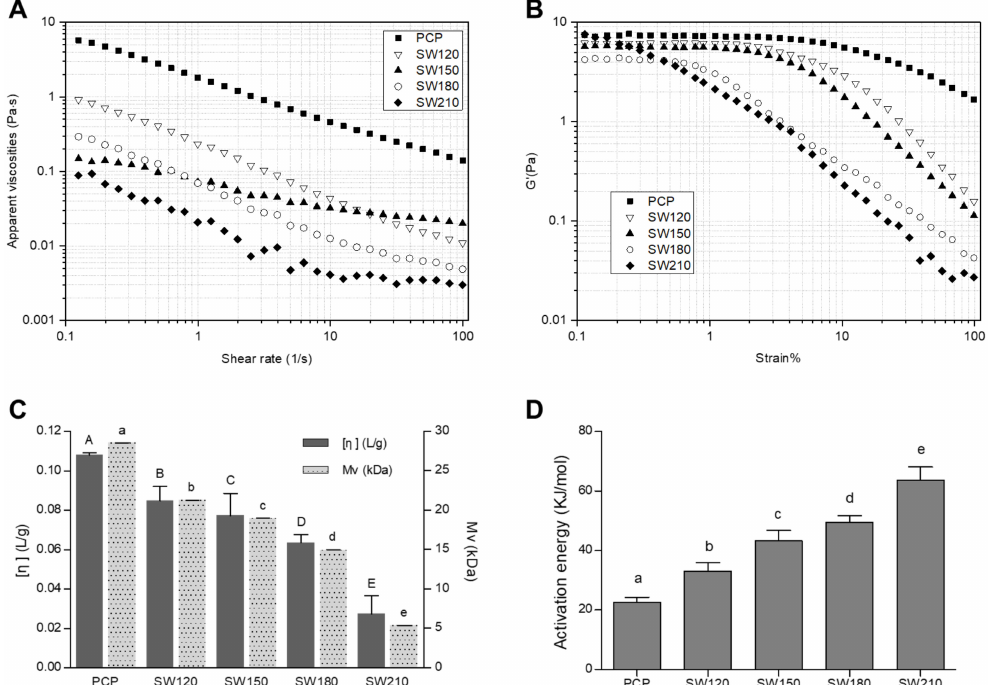
Figure 2. Apparent viscosities ( A ), storage modulus (G’) curves ( B ), intrinsic viscosity ([ η ]) and viscosity-average molecular weight (Mv) ( C ), and activation energy ( D ) of variety polysaccharides solutions under different SCW conditions. Data were expressed by means ± standard deviations ( n = 3). Values with different letters are significantly different ( p < 0.05). PCP, pumpkin crude polysaccharides; SW120, PCP under subcritical water 120 ◦ C treatment; SW150, PCP under subcritical water 150 ◦ C treatment; SW180, PCP under subcritical water 180 ◦ C treatment; SW210, PCP under subcritical water 210 ◦ C